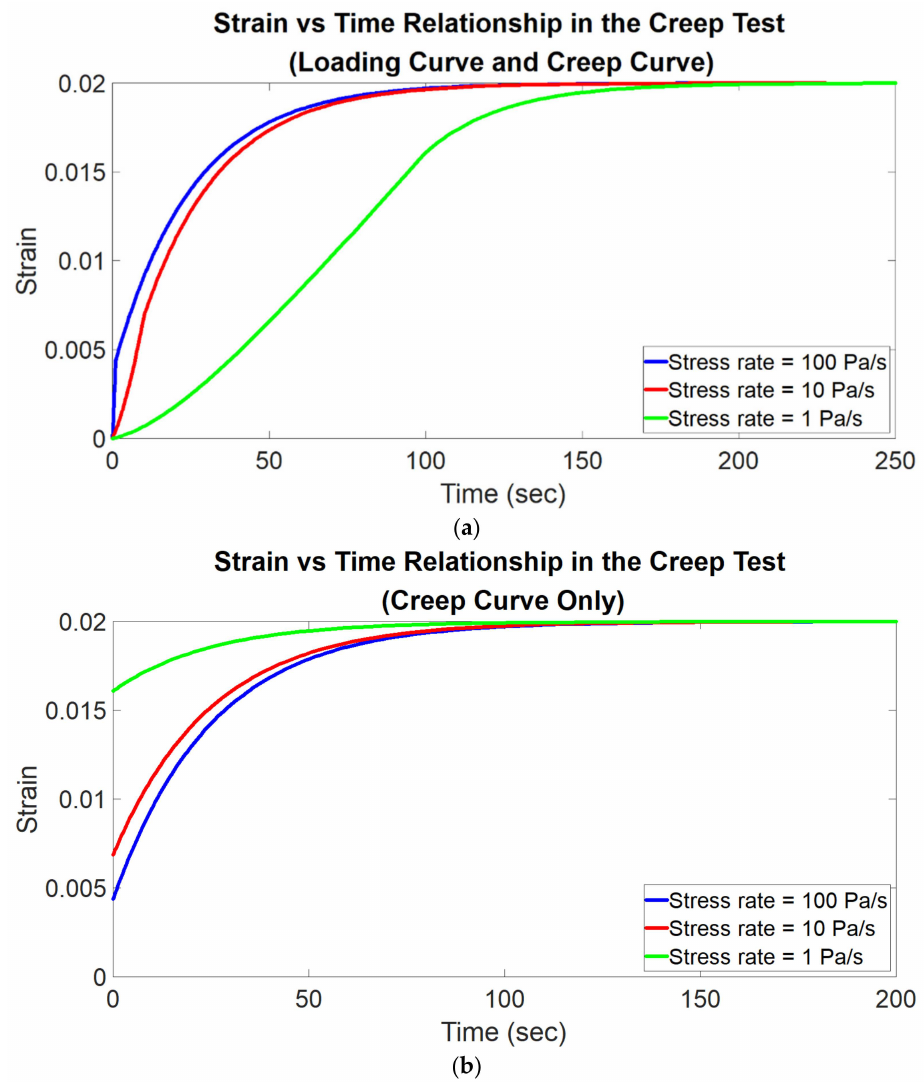
Figure 5. Illustration of an example of a series of simulated creep curves with associated loading curves measured with different stress rates. ( a ) Loading curve and creep curve. ( b ) Creep curve